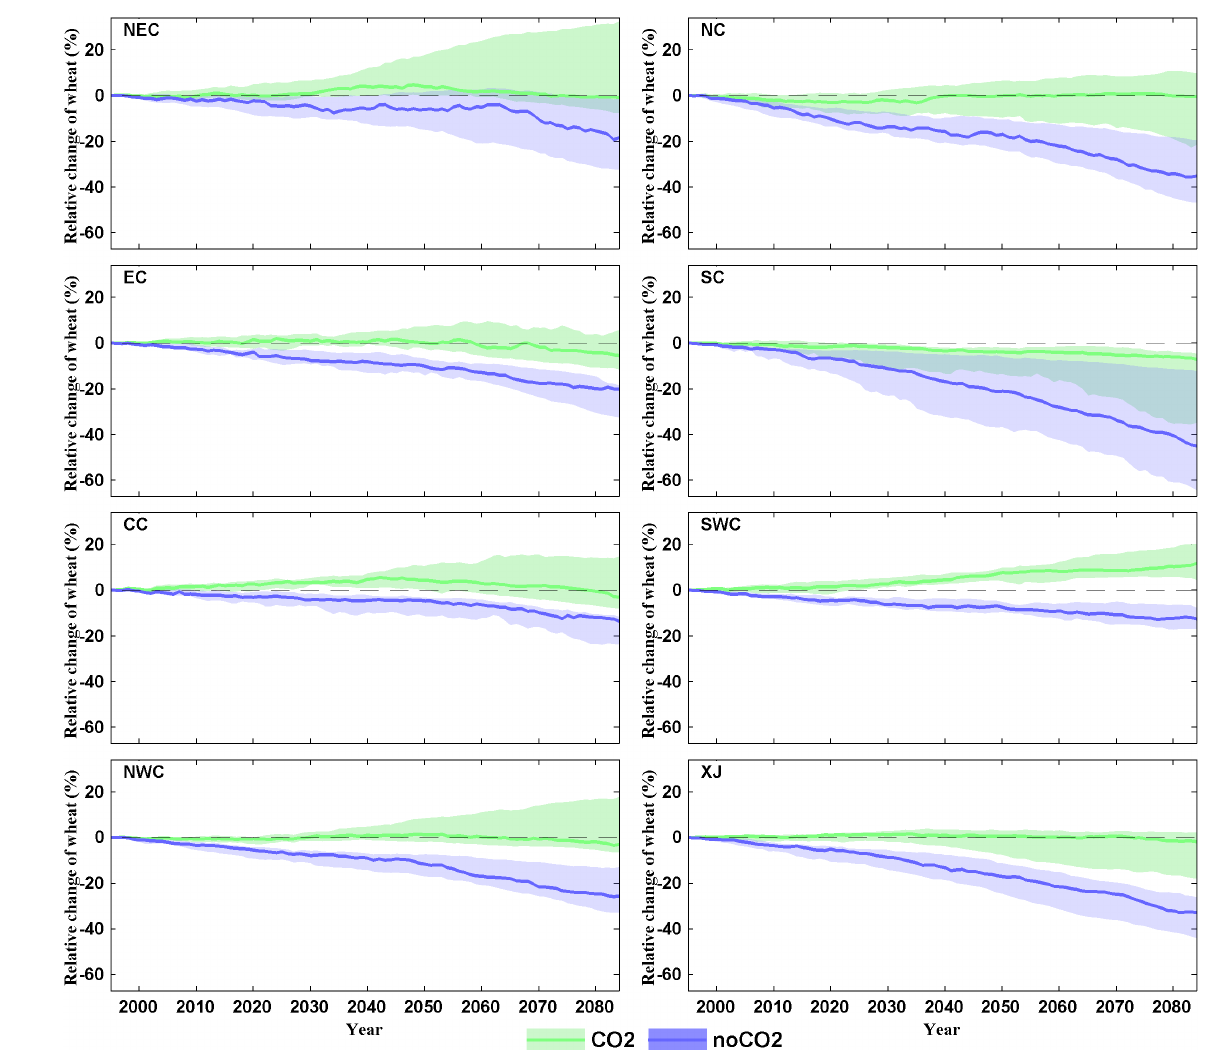
Figure 7. The relative change in the simulated wheat yield in the eight regions with and without the CO 2 effect. The MMs and the 25th and 75th percentiles of the model pairs are